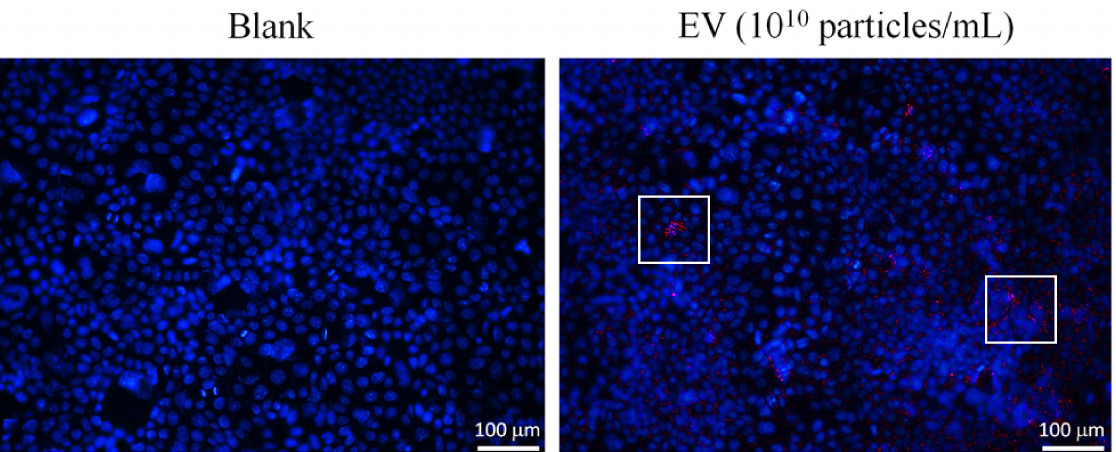
Figure 5. Observation of L. crispatus -derived EVs (final concentration: 10 10 particles/mL) entering 3A-sub-E placental cells after 12 h of treatment viewed via confocal microscopy. Red fluorescent: labelling-EV.